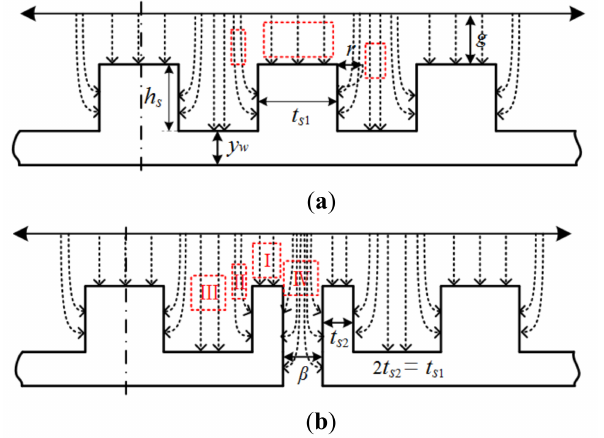
Figure 4. Path of flux lines in air-gap for different machines. ( a ) Traditional stator machine. ( b ) The machine with stator flux